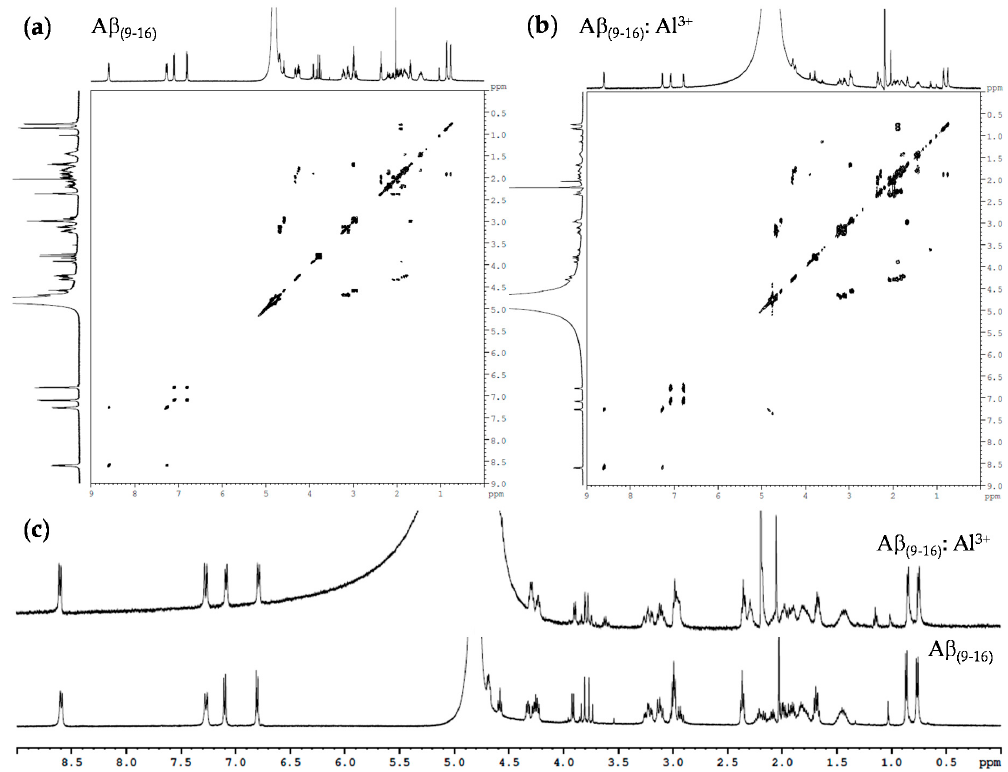
Figure 14. 1 H-NMR spectra of A β (9–16) peptide in the presence of aluminium sulphate: ( a ) COSY 1 H NMR spectrum of A β (9–16) peptide; ( b ) COSY 1 H NMR spectrum of A β (9–16) in the presence of Al 3+ ; ( c ) 1 H-NMR spectra.